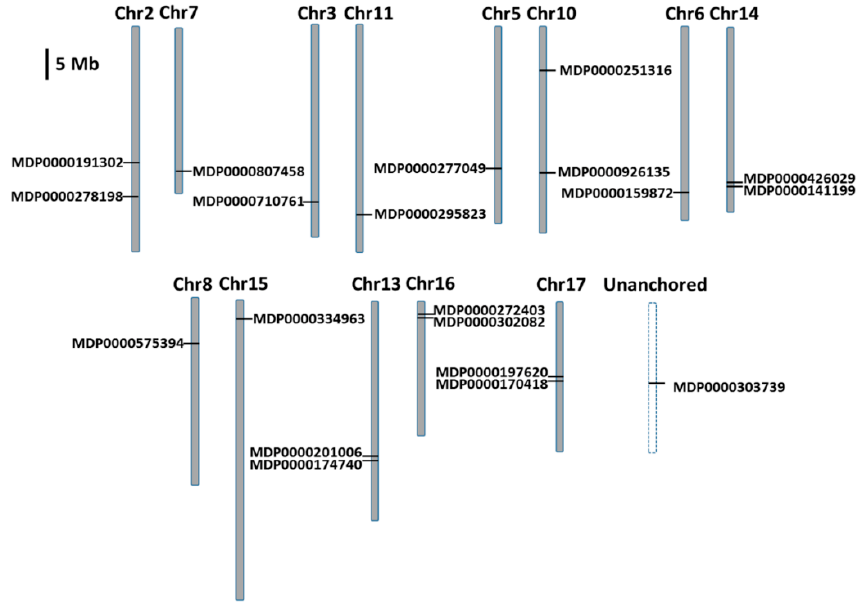
Figure 2. Chromosomal location of the apple MDH genes; the dashed line indicates the anchored sequences.